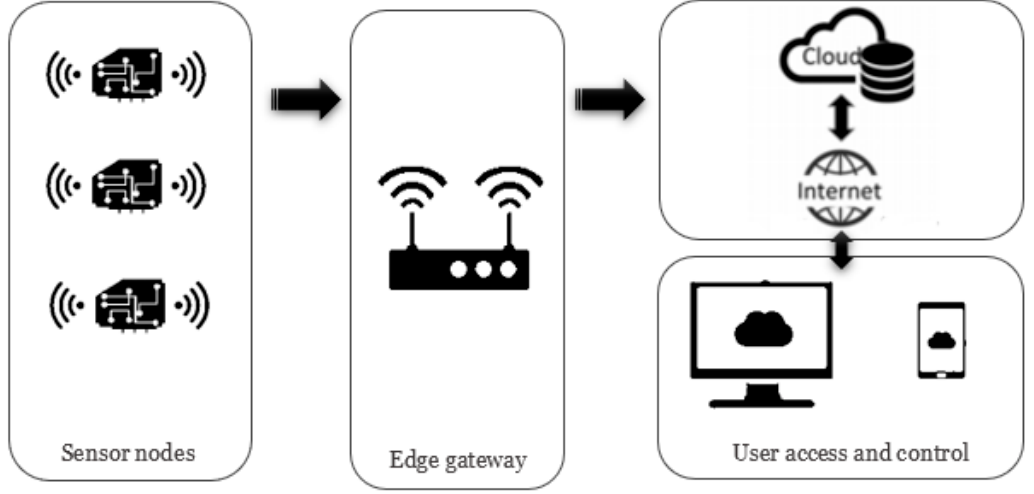
Figure 6. Schematic representation of the main components of IoT.